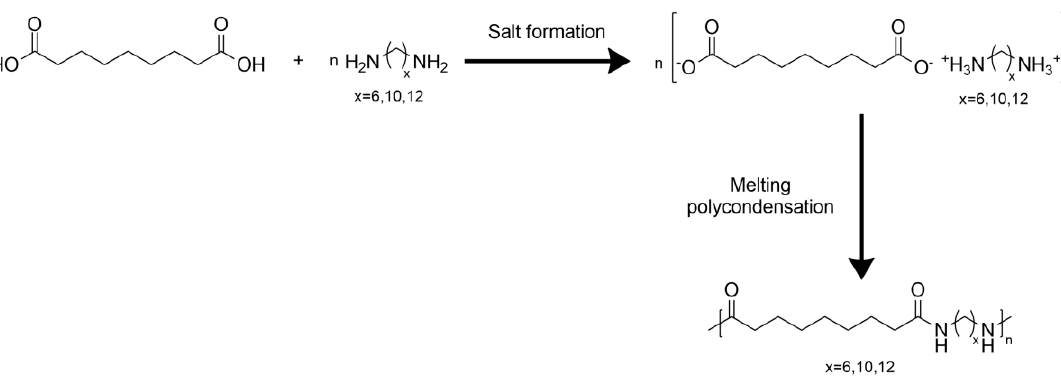
Figure 5. Synthesis and chemical structure of polyamide 6,9, polyamide 10,9 and polyamide 12,9.